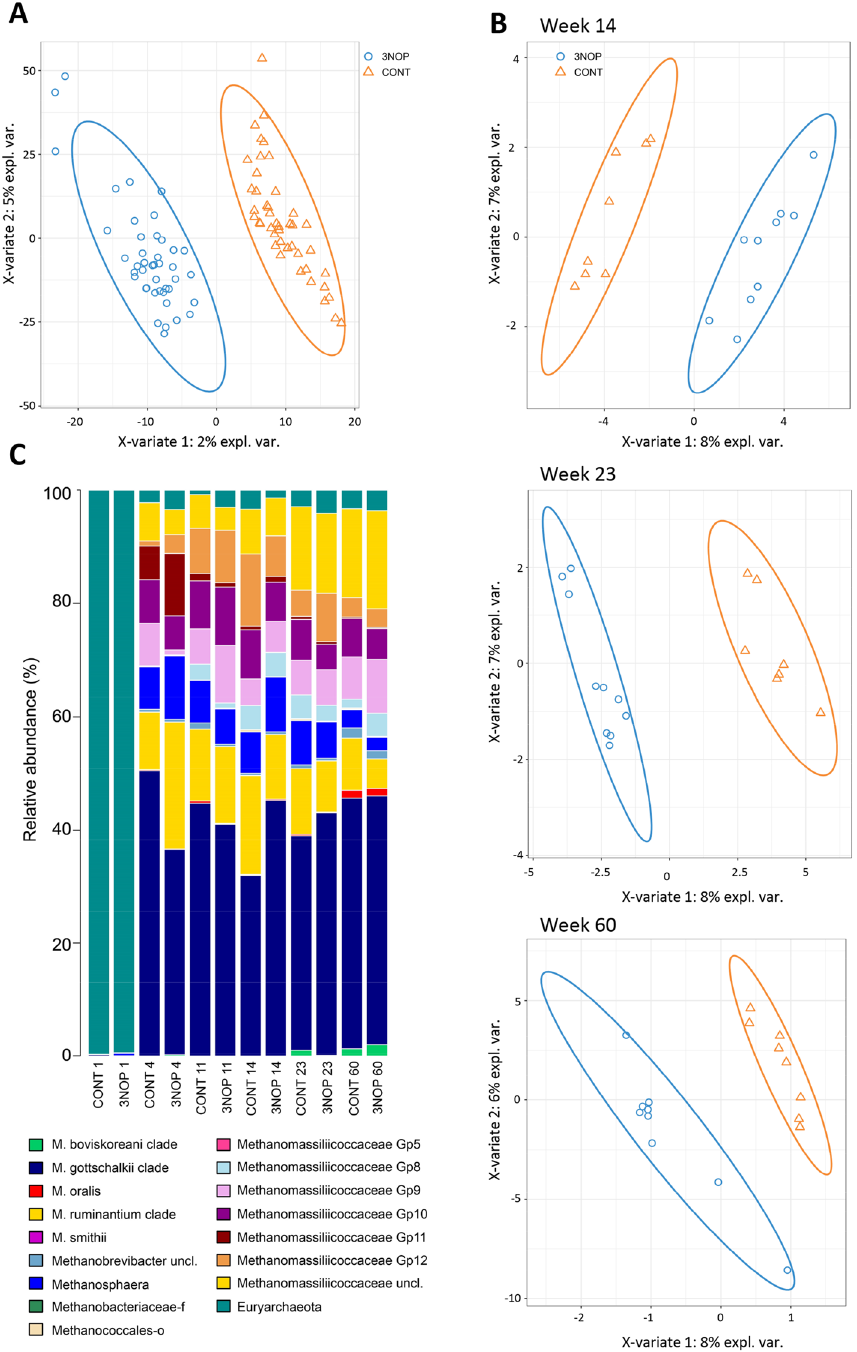
Figure 3. Ruminal archaeal structure differed with 3-NOP supplementation of calves from birth. Sparse- PLS-DA loading weights plot of archaeal structure across all weeks of age showing separation of the two treatment groups, blue = 3-NOP, and orange = CONT( A ); Sparse-PLS-DA loading weights plots of archaeal microbial structure at week 14, 23 and 60 ( B ), showing clear separation of treatment groups; Relative abundance of archaeal taxa across all weeks ( C